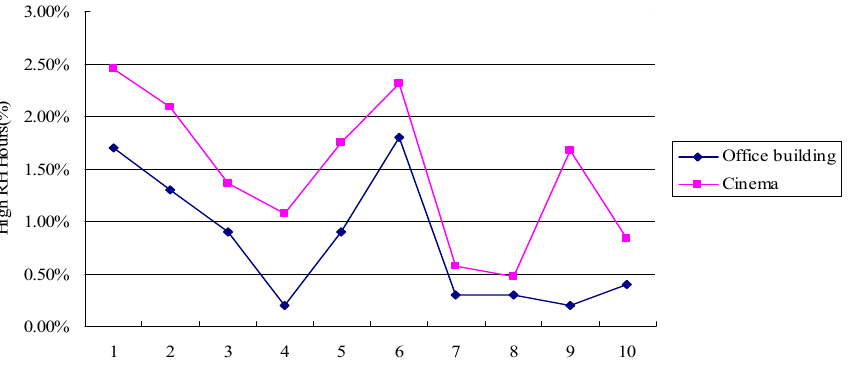
Figure 7. The energy savings in FA between the cinema and the office building.